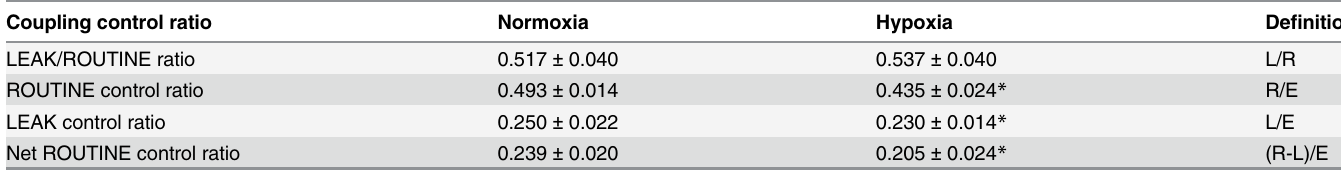
Table 4. Coupling control ratios (CCRs) derived from the protocol with intact cells. Coupling control ratio LEAK/ROUTINE